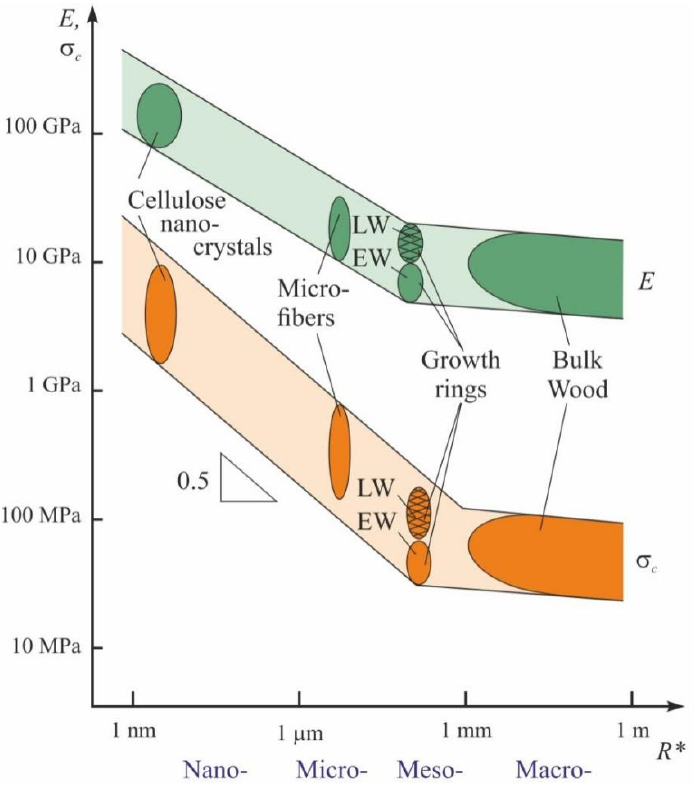
Figure 12. The size dependence of cellulose-containing materials strength. (Data collected by the authors). R* is the characteristic size.